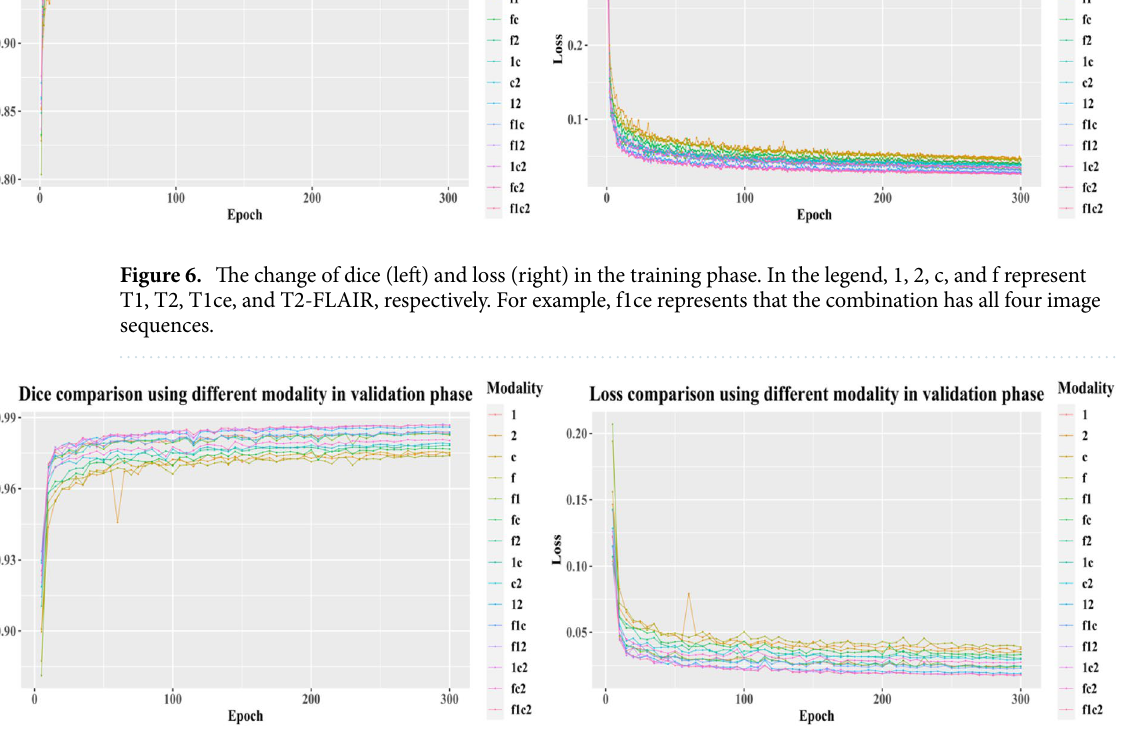
Figure 7. The change of dice (left) and loss (right) in the validation phase. To save training time, we execute the validation part in every 5 epochs. In the legend, 1, 2, c, and f represent T1, T2, T1ce, and T2-FLAIR, respectively. For example, f1ce means that the combination has all four image